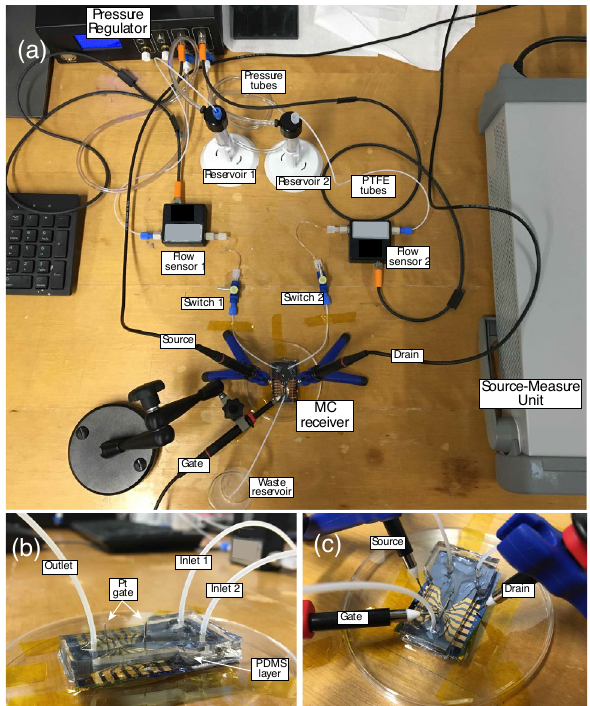
Figure 6. ( a ) Microfluidic measurement setup consisting of a 4-channel pressure regulator, a high-precision SMU, electrical probes and microfluidic accessories. ( b ) A closer look into the fabricated graphene-based MC receiver connected to the microfluidic setup. ( c ) Probe connections for electrical tests of the